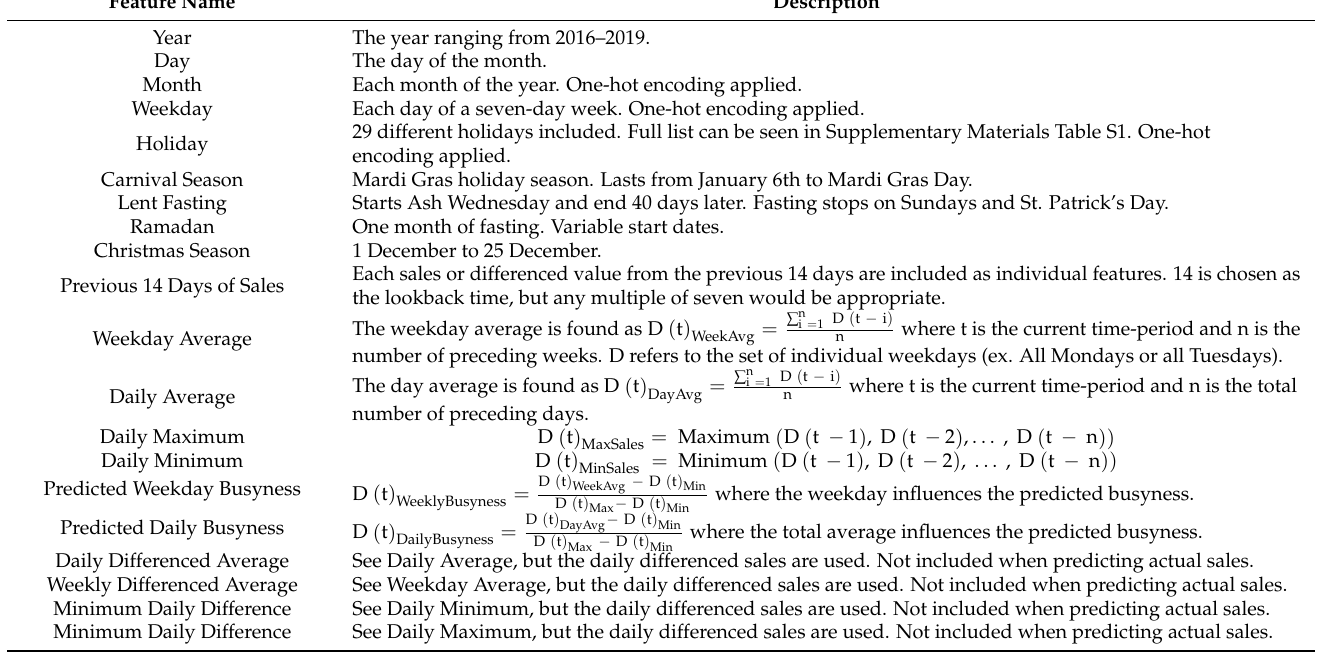
Table 1. We display each feature used for prediction and a description of that feature.